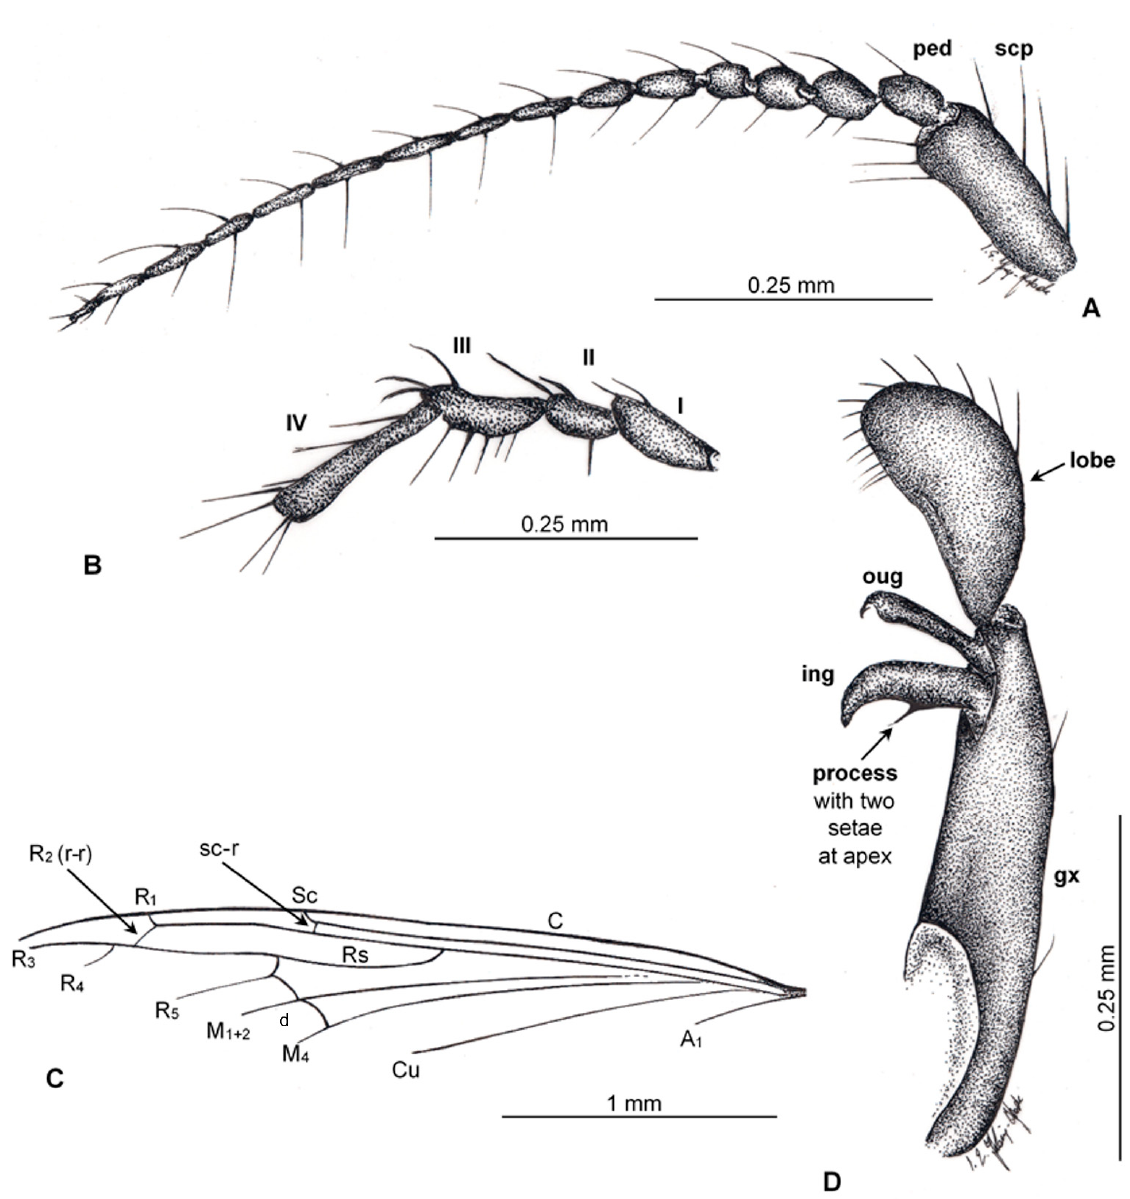
Figure 2. Trichoneura ( Cretalinea ) xavieri subgen. et sp. nov., holotype No. MCNA 9735 (male). ( A ) antenna; ( B ) palpus; ( C ) preserved of part of wing; ( D ) gonostyli and gonocoxites. Abbreviations: scp—scape; ped—pedicel; I–IV—palpomeres 1–4; ing—inner gonostylus; oug—outer gonostylus; gx—gonocoxite.